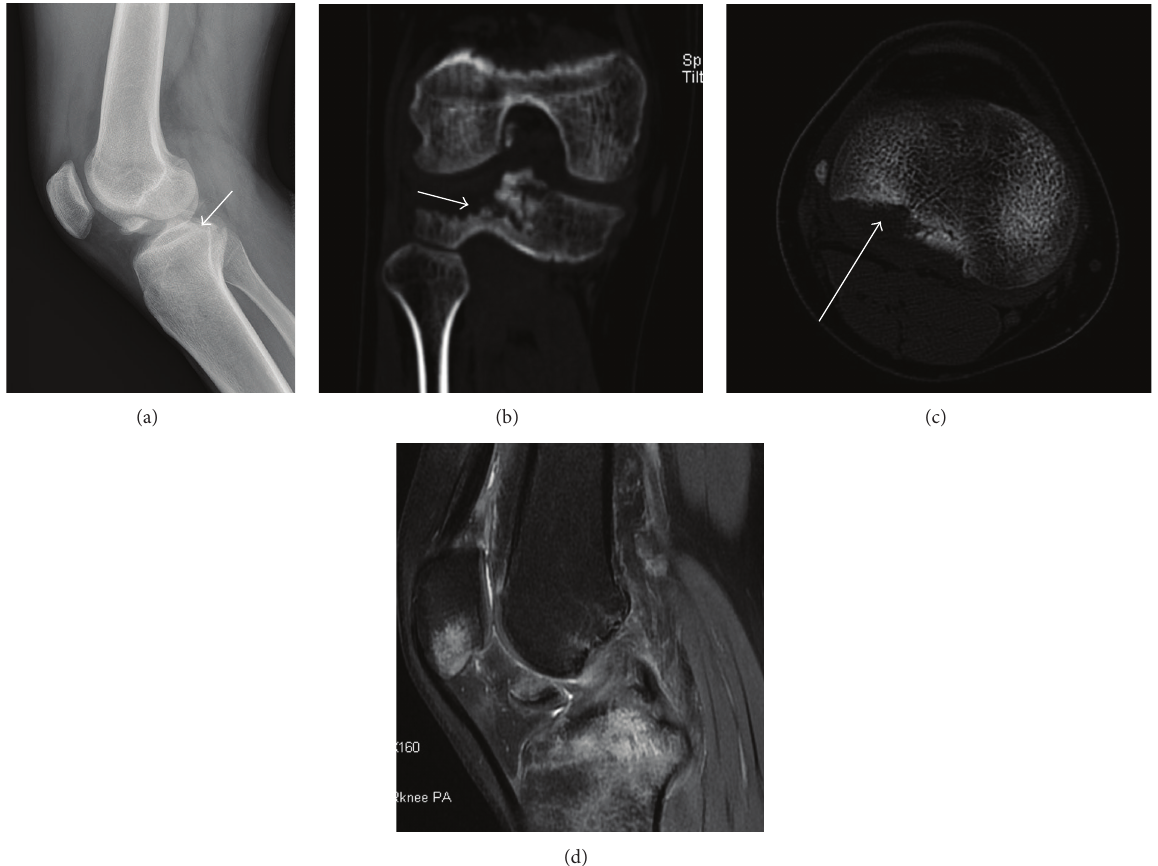
Figure 1: Imaging examinations of the first patient. The X-ray image (a) shows a posterolateral tibial plateau fracture (white arrow). In CT scans (b and c), a posterolateral tibial plateau fracture is found (white arrow). In the MRI image (d), a tortuous ACL was confirmed with the patella and tibia had a bone bruise. No patella fracture was found. There was a fracture fragment in the